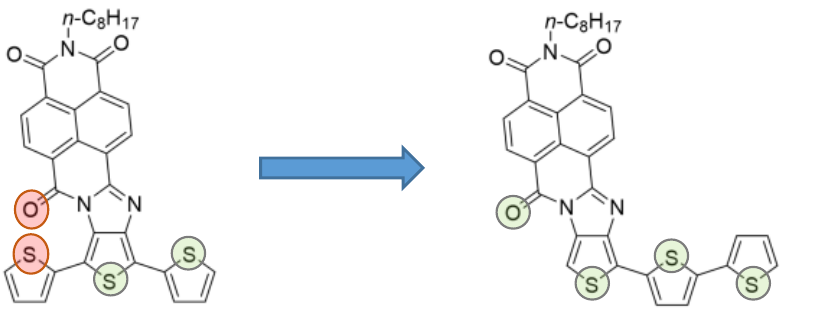
Figure 5. Schematic representation of oxygen–sulfur repulsive interaction (highlighted in red) in the first generation of NDI-oligothiophene derivatives and how it is suppressed in the second generation.